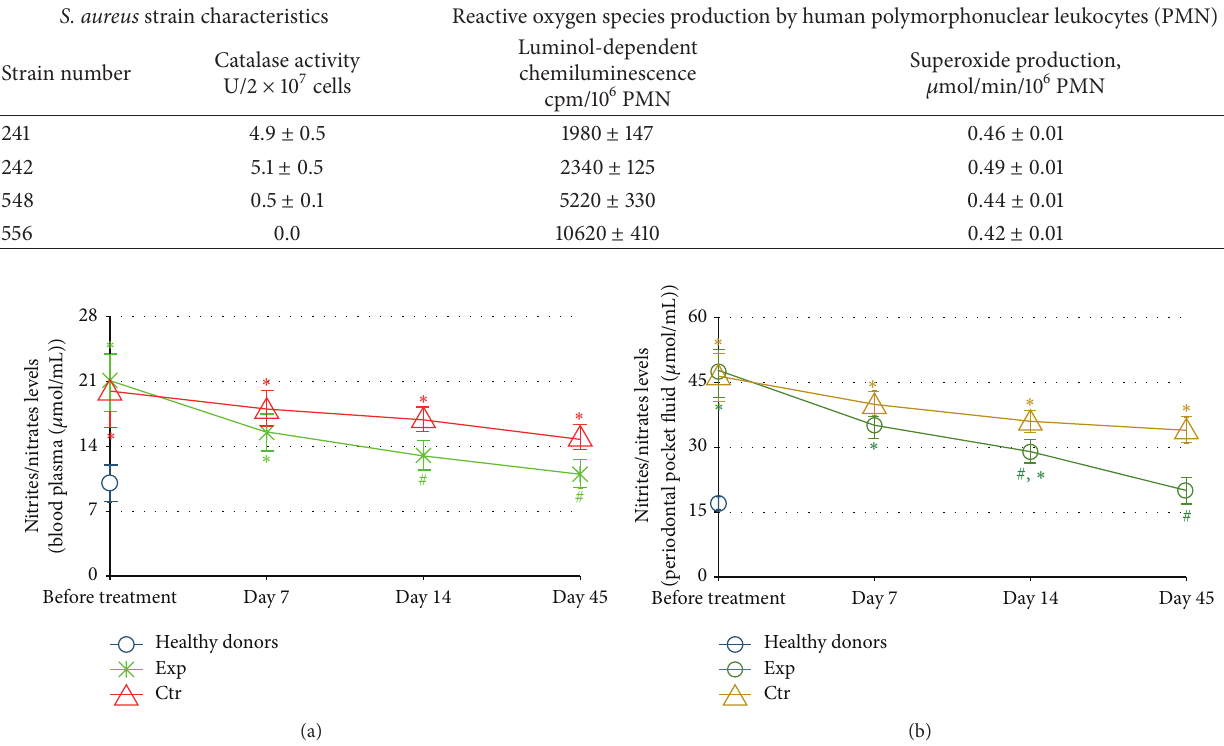
Table 2: Effects of S. aureus strains with different catalase activity on reactive oxygen species production by human granulocytes. S. aureus strain characteristics